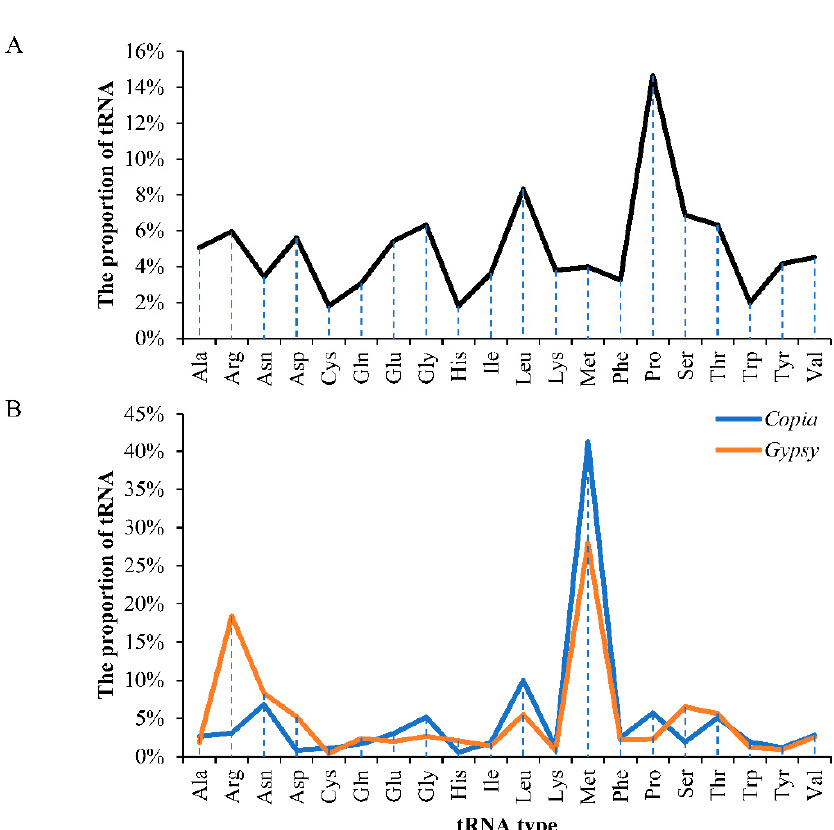
Figure 1. Statistics of tRNA usage in different superfamilies. ( A ) The proportion of different tRNAs in the mulberry genome; ( B ) Comparison of tRNA usage of different superfamilies. The x -axis denotes different tRNAs. The y -axis represents proportion of tRNA.